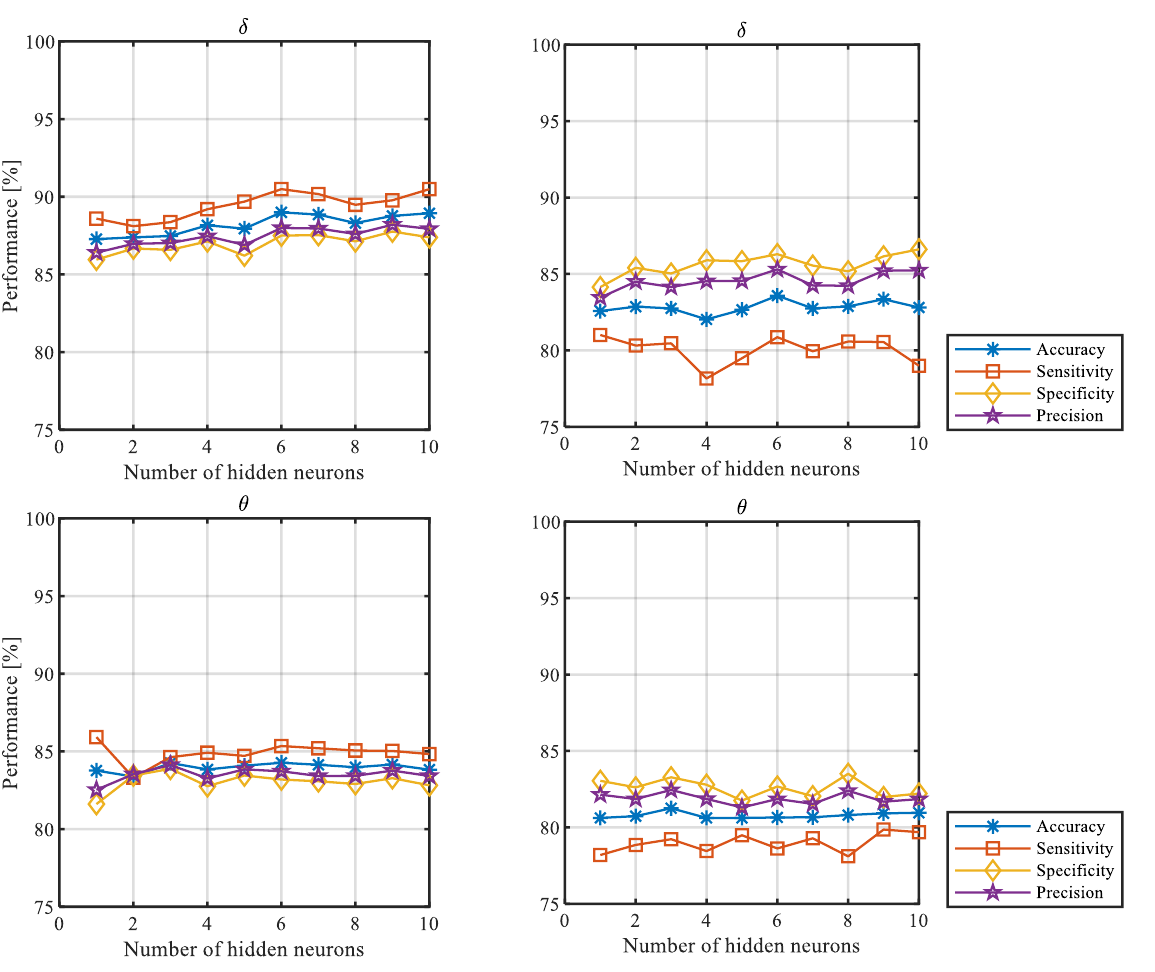
Figure A1. Network classification measures for selected single frequency bands ( δ , θ ), where the training and testing feature set vectors were separated by different parts of the same sessions ( left , the first scenario) and different sessions ( right , the second scenario).